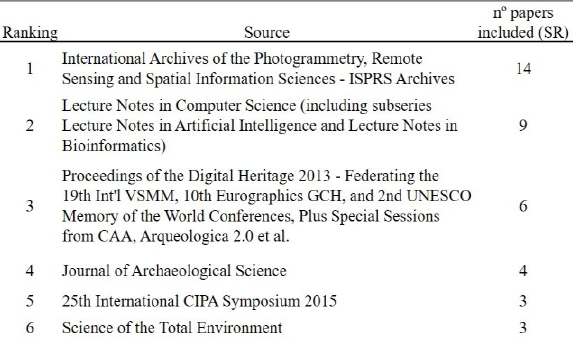
Table 04: List of sources of publications with more than three articles.